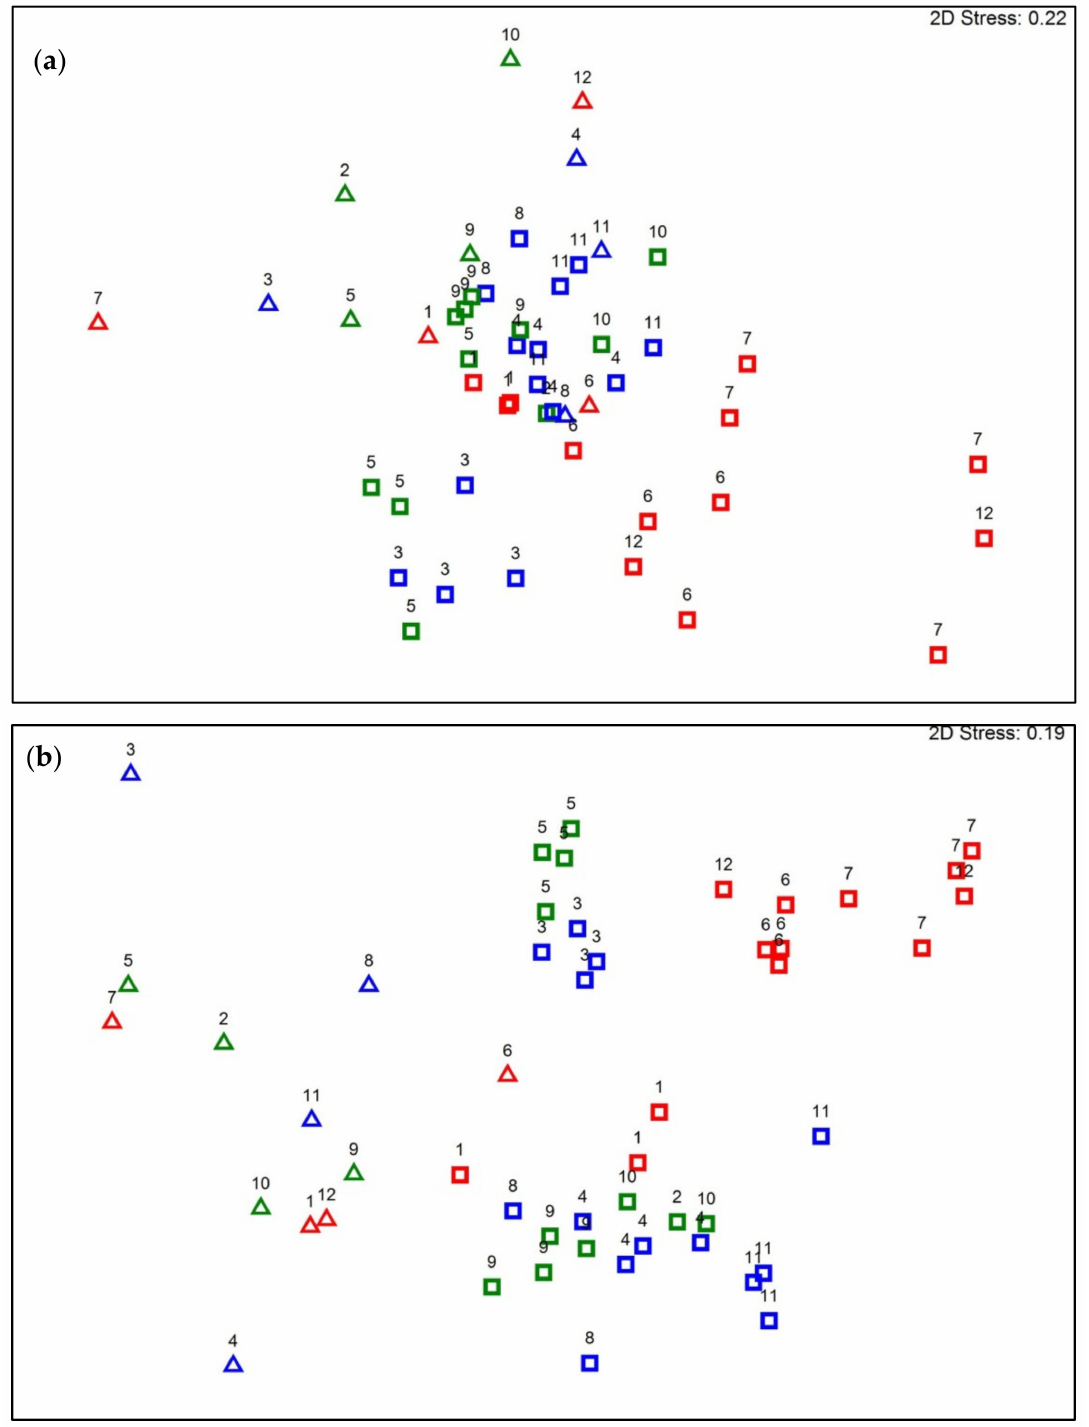
Figure 2. Nonmetric multidimensional scaling (MDS) analyses showing the similarity/dissimilarity between sampling sites and sample types using two different matrices: ( a ) Jaccard (presence/absence of each OTU) and ( b ) Bray–Curtis (relative abundance of each OTU). Matrices were determined from OTUs at 97% identity. Numbers represent fountain numbers (see Figure 1). Sample types are water (squares) and biofilm (triangles). Fountain types are indicated by color: (A) green, (B) blue and (C)